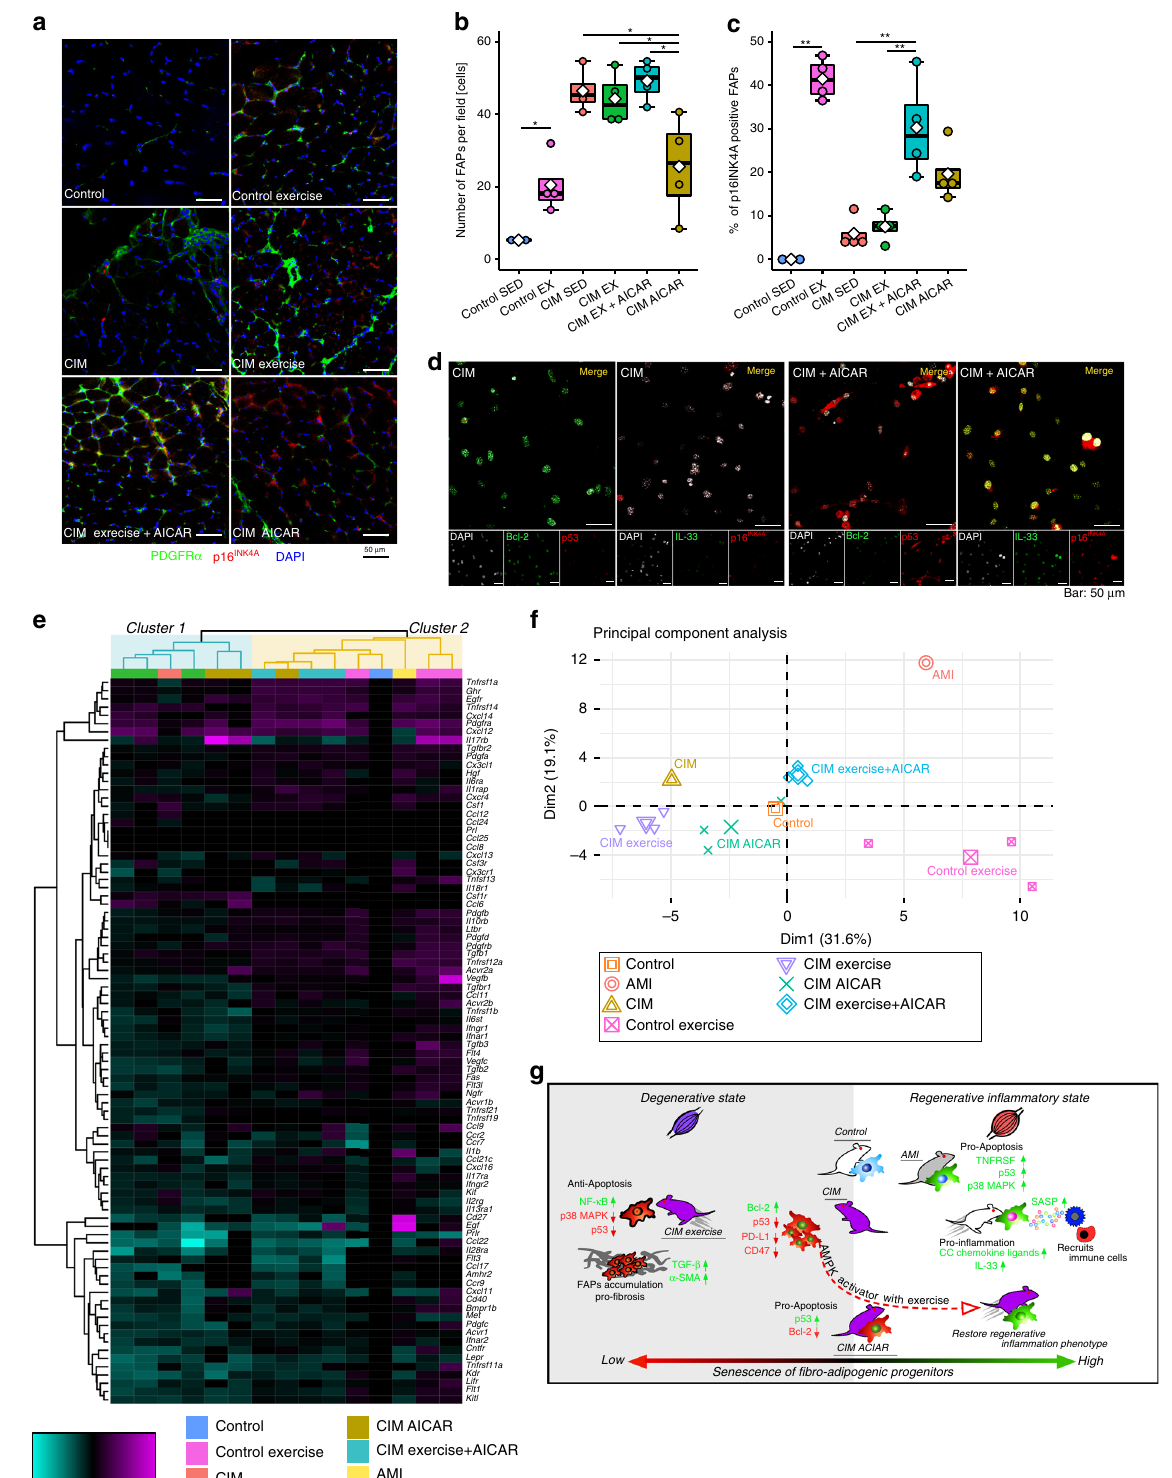
Methods Animals . The Committee of the Animal Experimentation Center of the Sapporo Medical University School of Medicine approved all animal protocols. Mice were maintained in an enclosed, pathogen-free facility. Female BALC/c and C57BL/6 mice (age >6 weeks; Sankyo Lab Service, Tokyo, Japan) were used in all experi- ments. B6.Cg-Trp53 <tm1Sia>/Rbrc mice ( C57BL − p53 + / − ) (Accession No. CDB 0001K) were provided by the RIKEN BioResource Center (Ibaragi, Japan) 69